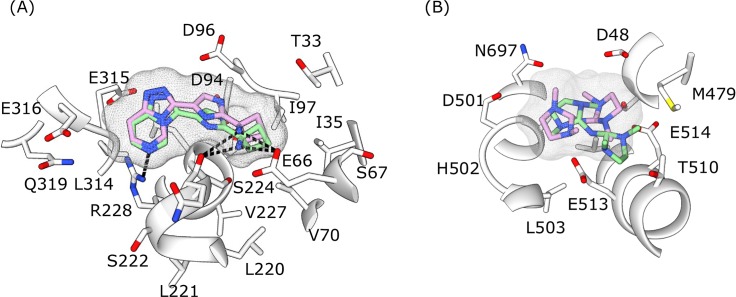
The docked poses of ZINC94258558 bound to N protein (A) and ZINC91252717 bound to P protein (B) as predicted by Autodock4 (green sticks with surface mesh) and Dock6.8 (lilac sticks with surface mesh). The protein is represented in white ribbons with the residues interacting with ligand shown in stick representation. Hydrogen bonds (only displayed in A) are shown as dashed lines.